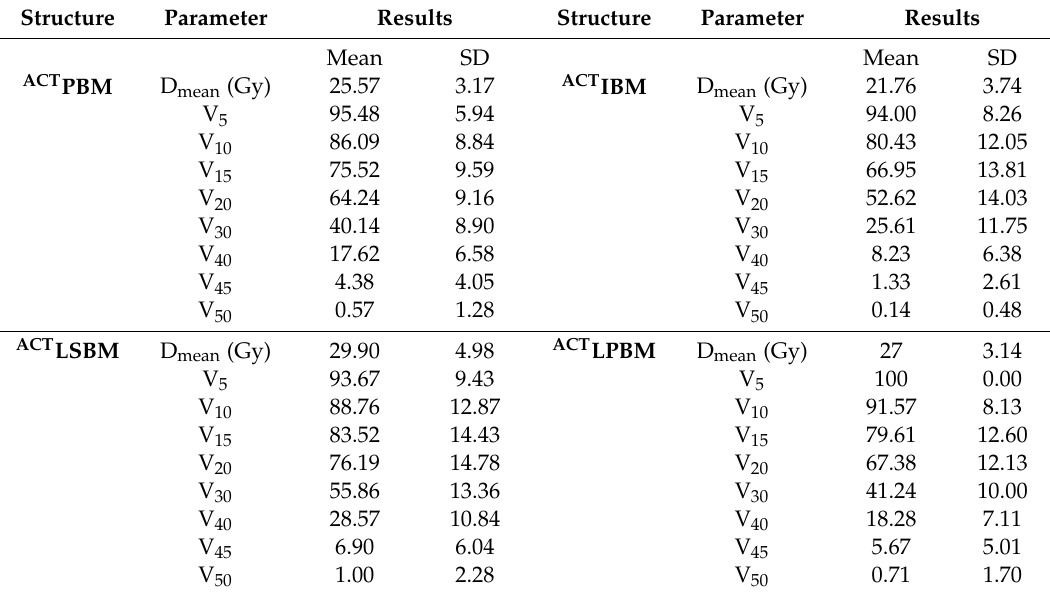
Table 6. Dosimetric parameters for pelvic active bone marrow.